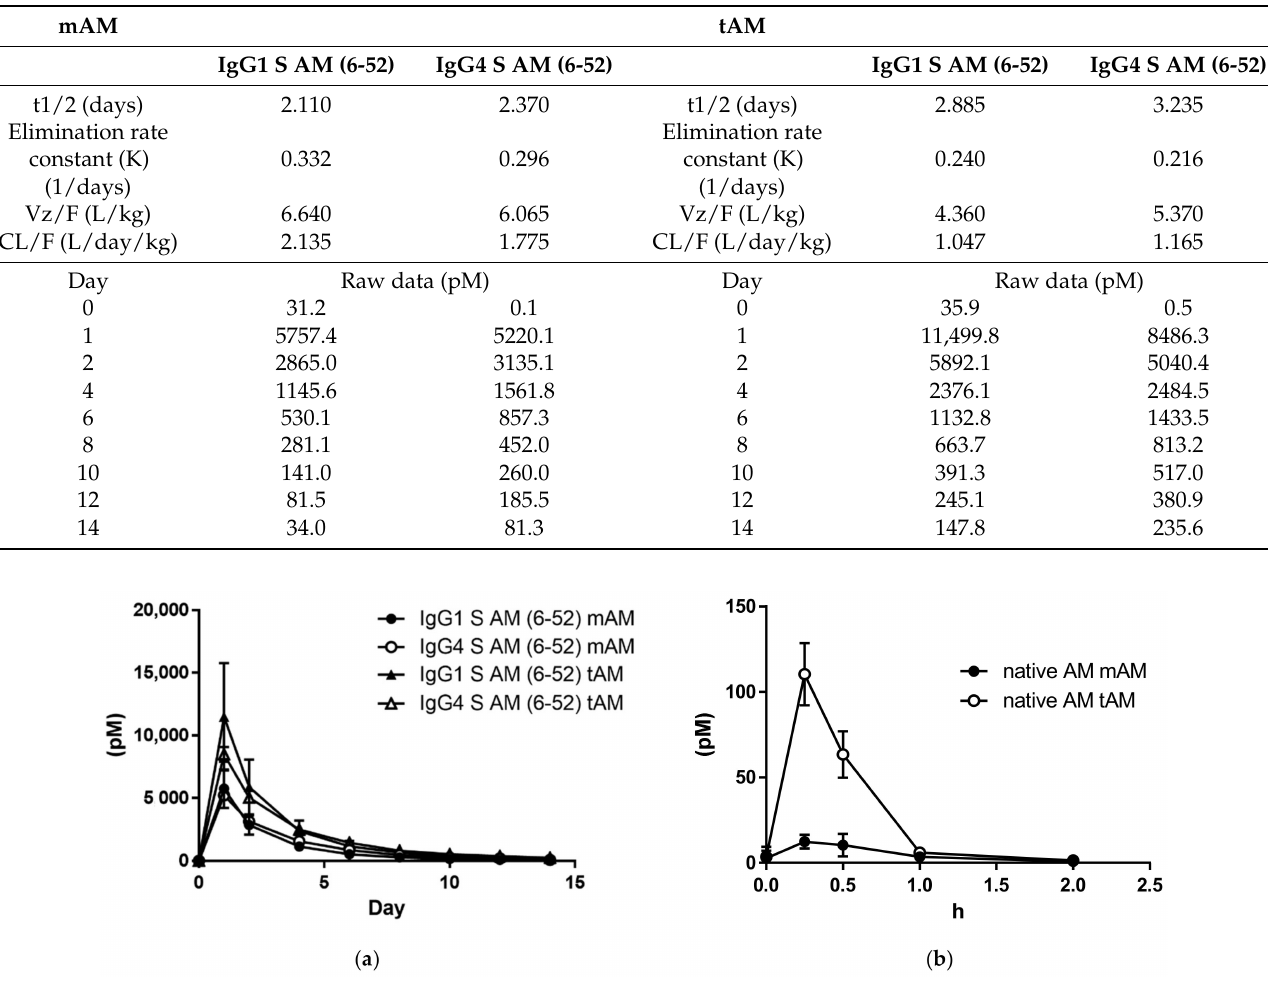
Table 1. The PK parameters (Vz/F, CL/F, T1/2, and Ke) and concentrations of mAM and tAM.